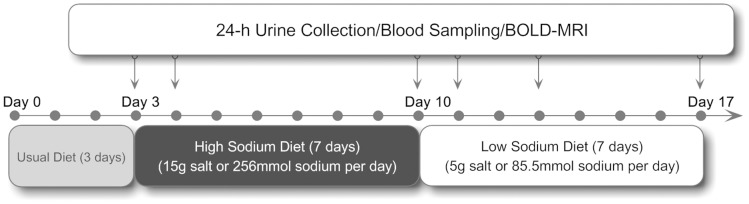
Research protocol.